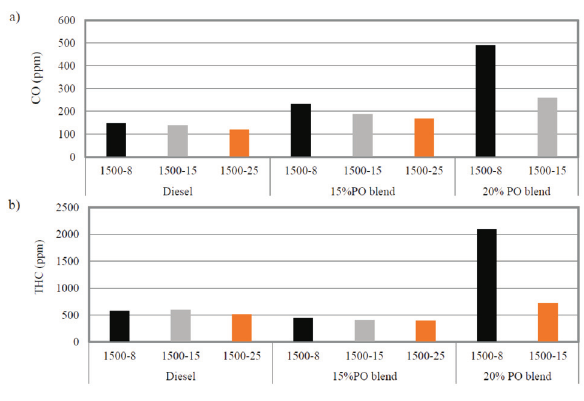
Fig. 10. Carbonaceous emissions